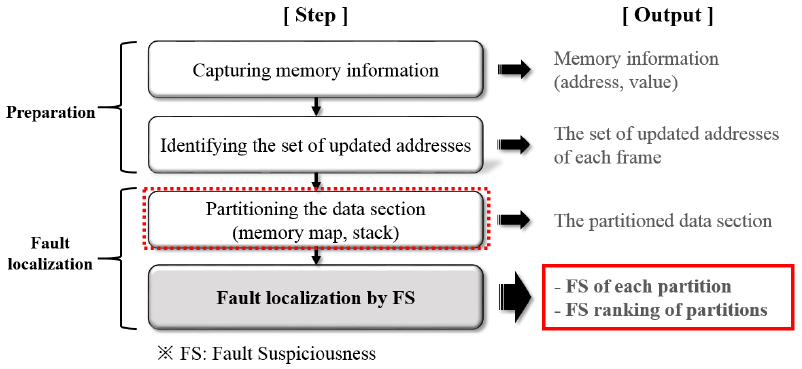
Figure 6. Process of fault localization.